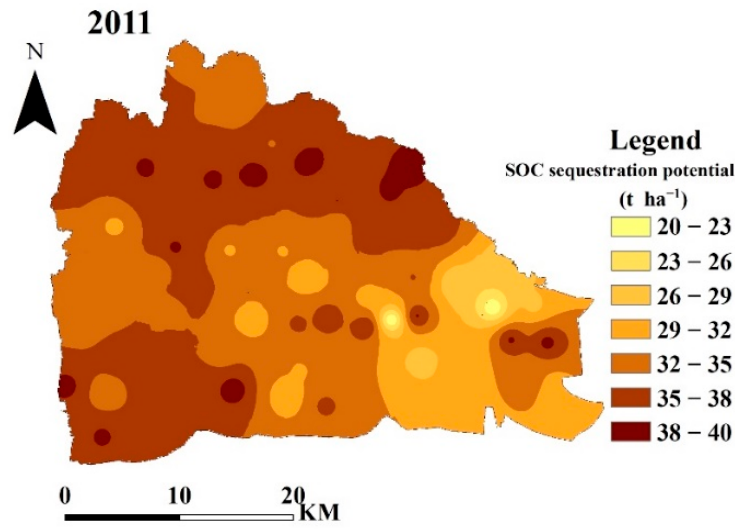
Figure 4. Carbon sequestration potential distribution map of Fengqiu county from 2011.